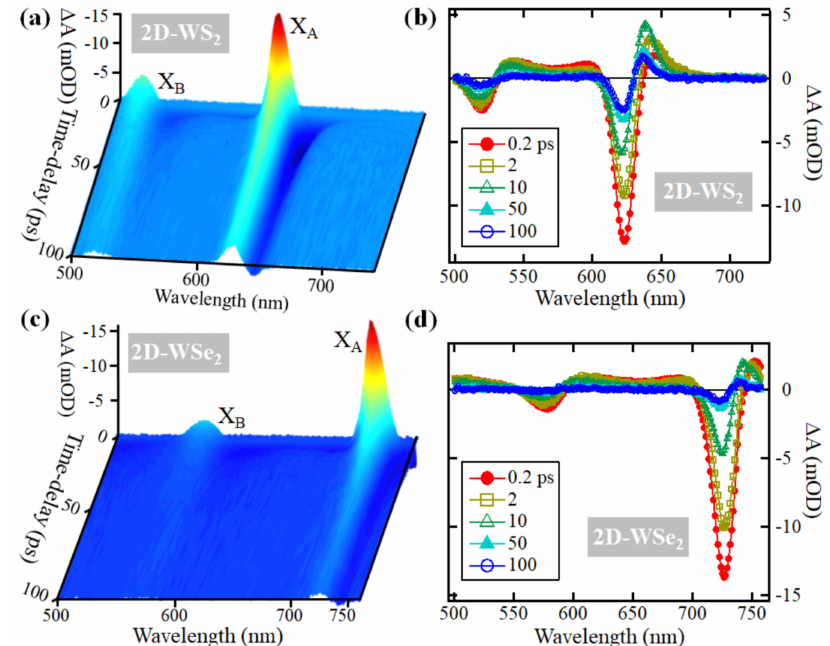
Figure 2. ( a ) Transient absorption results following excitation at ~400 nm (~3.1 eV) with a fluence of ~4 µ J · cm − 2 of a single crystal of 2D-WS 2 monolayer. ( b ) Spectral cuts at different time-delays from ( a ). ( c ) Transient absorption results following excitation at ~400 nm (~3.1 eV) with a fluence of ~2.8 µ J · cm − 2 of a 2D-WSe 2 single crystal monolayer. ( d ) Spectral cuts at different